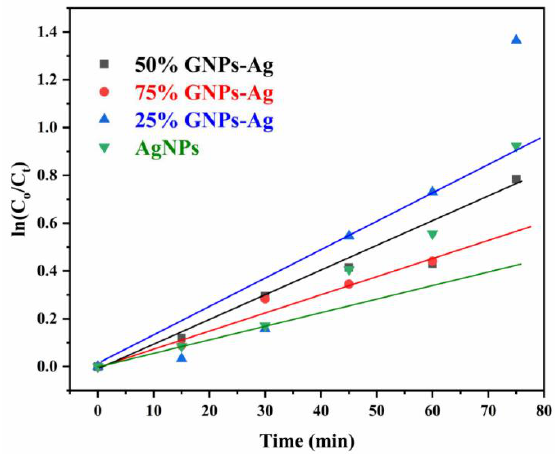
Figure 14. Pseudo-first-order kinetics of catalyst (Ag) 1−x (GNPs) x against MB.